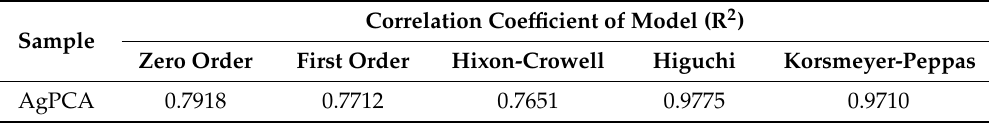
Table 1. Kinetic assesment of AgPCA based on various kinetic mathematical models.